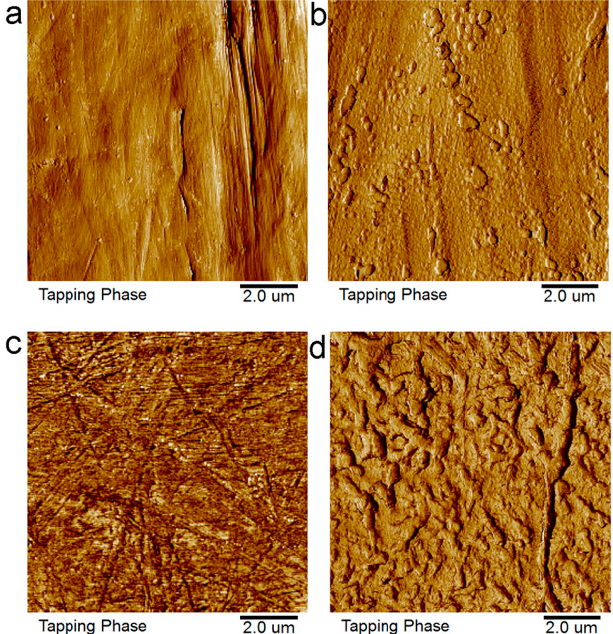
Figure 7. AFM phase images of polymer surfaces: ( a ) untreated PE; ( b ) treated PE; ( c ) untreated POM; ( d ) treated POM.